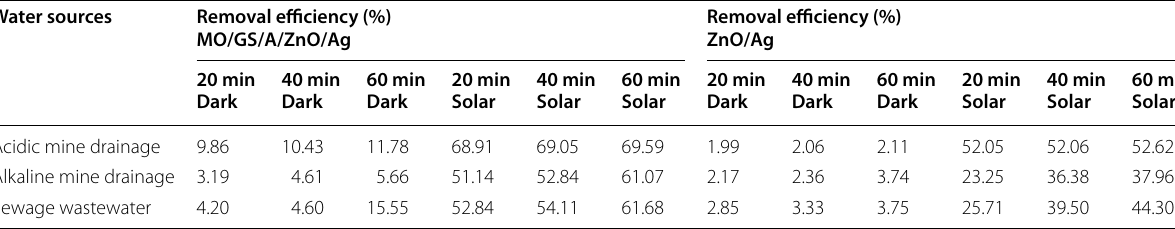
Table 8 Removal efficiency of PAHs in contact time Water sources